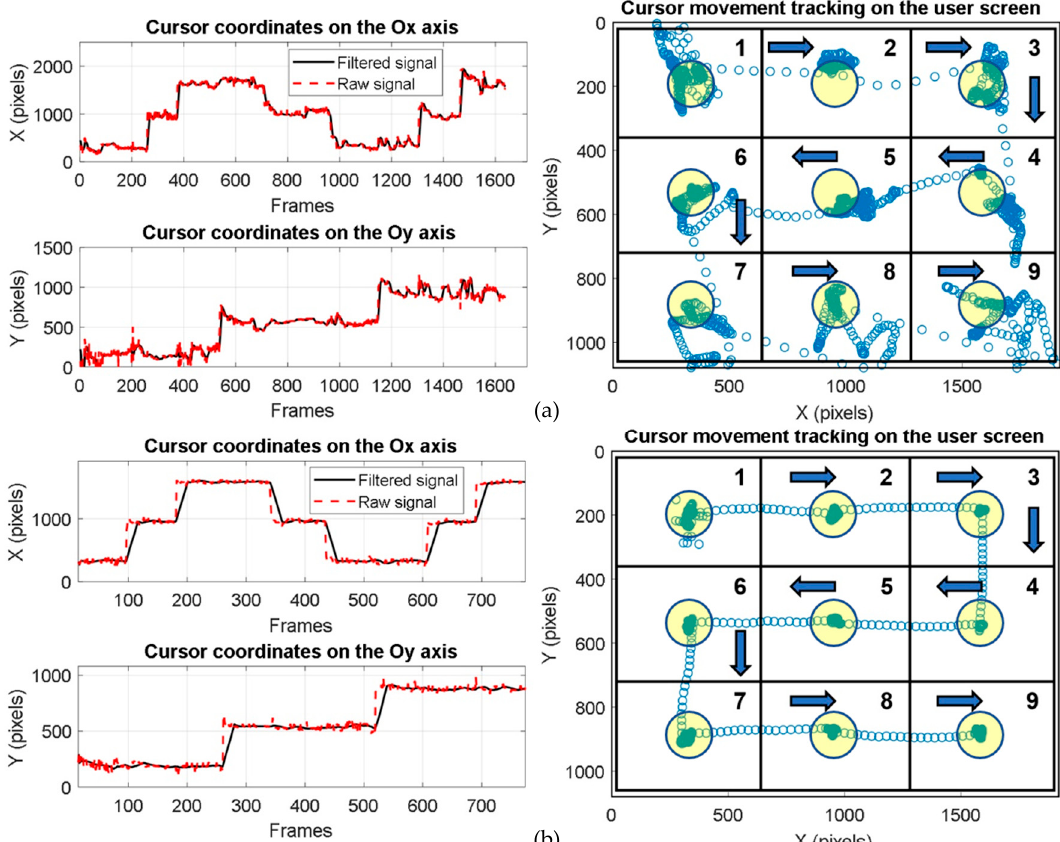
Figure 20. Signals provided by pupil detection algorithms (PDA) on both axes of the coordinate system and cursor movement tracking on the user screen: ( a ) non-experienced user; ( b ) experienced user.